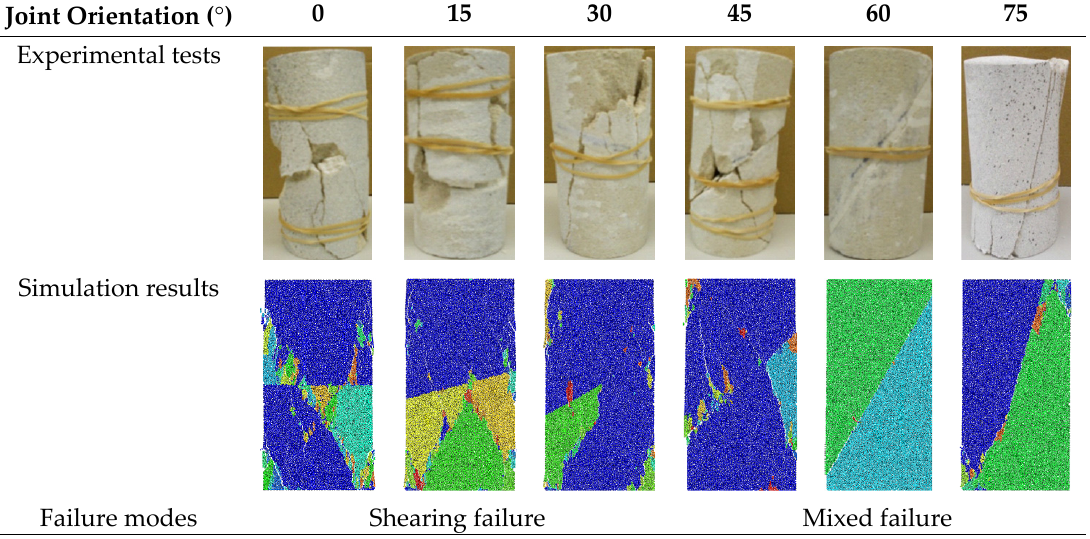
Figure 10. The comparison post-failure images and modes between experimental tests from [8] and numerical results.